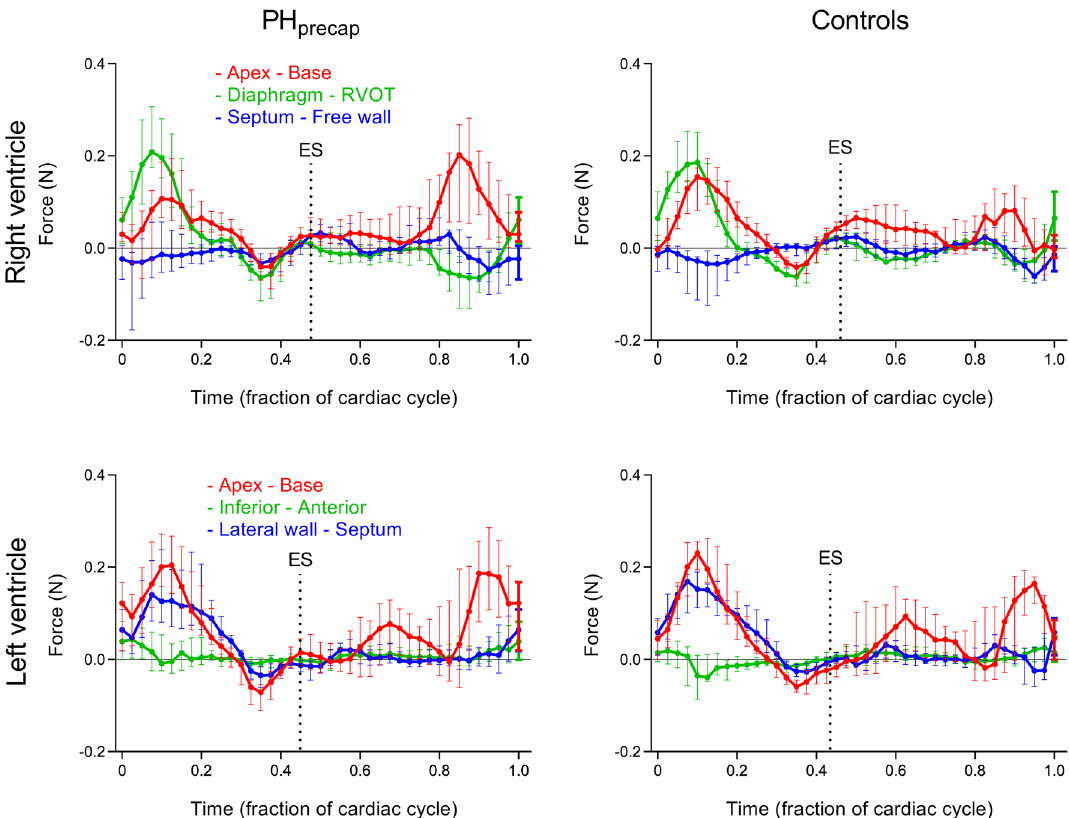
Figure 3. Right (top row) and left (bottom row) ventricular hemodynamic forces over one cardiac cycle in patients with precapillary pulmonary hypertension (PH precap , left column) compared to healthy controls (right column). Force patterns are presented as median and interquartile range for each time point in all three directions respectively. Individual force curves for patients and controls are shown in Supplementary Figs. 2 (RV) and 6 (LV). ES, end systole; RVOT, right ventricular outflow